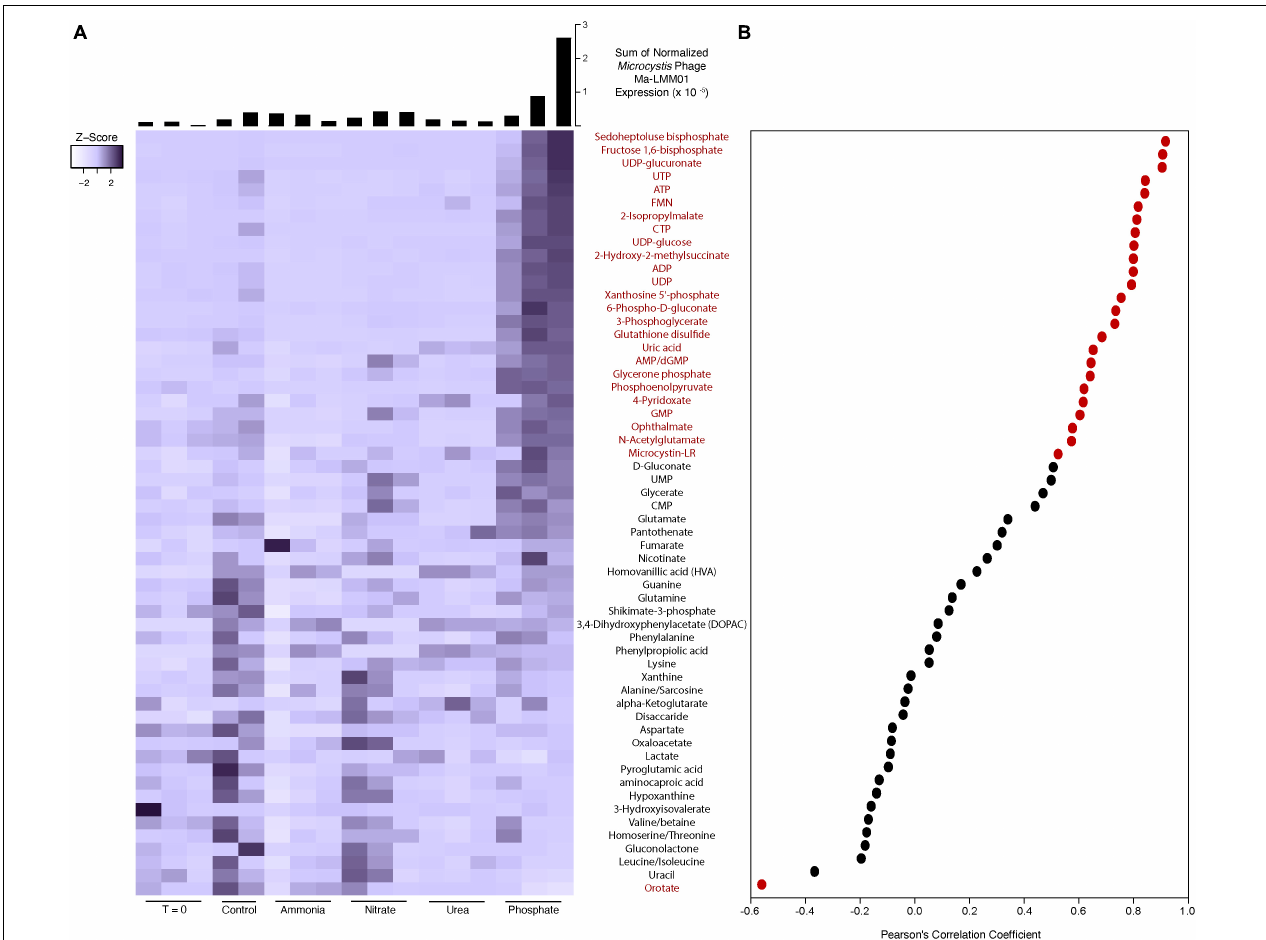
FIGURE 5 | Heatmap of metabolite peak intensities (A) . Color scale has been scaled to each metabolite ( z -score). Histograms describe the sum of normalized expression for Microcystis phage Ma-LMM01 in each experimental bottle. Expression was normalized to the library size of each sample and the length of each gene. Scatter plot shows the Pearson’s correlation coefficient between each metabolite detected and Microcystis phage Ma-LMM01 tail sheath normalized expression (B) . Red dots and metabolite labels indicate a significant correlation ( p < 0.05), while black dots and metabolite labels indicate correlations deemed to be non-significant statistically ( p >